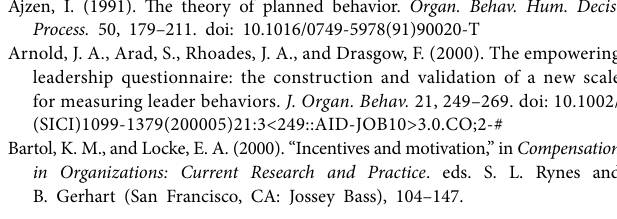
Conditional effects of leader empowering behavior on self-determination